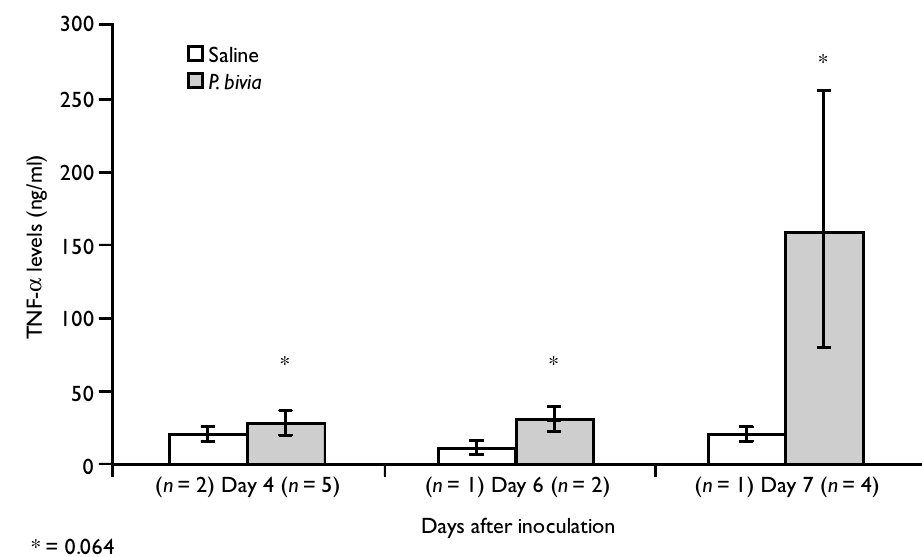
Figure 2 TNF- a levels in AF of rabbits inoculated with P. bivia or